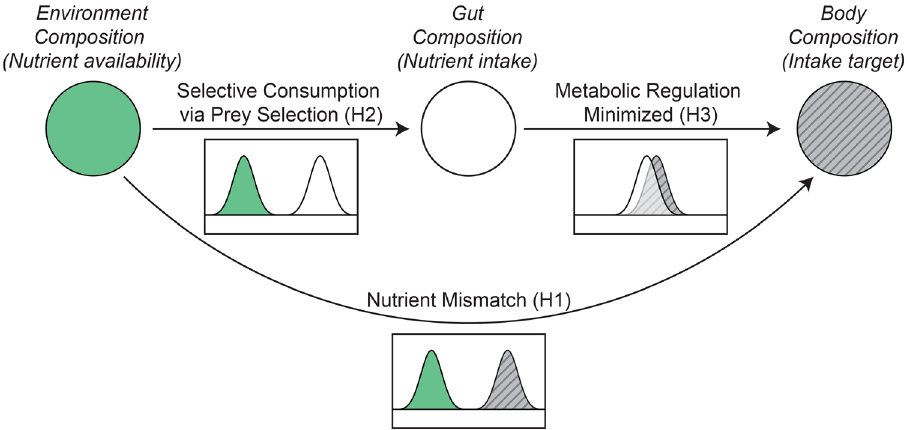
Figure 1. Comparisons among the environment (green), gut (white) and body compositions (‘intake target’; grey striped) of blackfish were used to test whether these carnivores selectively consume amino acids to match their intake target. H1) Lack of overlap between environment and the intake target indicates mismatch, i.e., amino acid deficiency and excess. H2) Lack of overlap between environment and the gut composition indicates amino acid intake is non-random. This may be achieved by selecting prey with particular amino acid profiles. H3) Overlap between gut and the intake target indicates selective consumption of amino acids towards minimising regulation